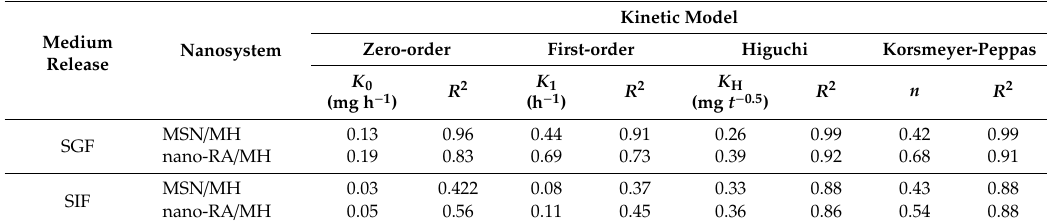
Table 2. Kinetics parameters of the release profile of nanosystems in simulated gastric fluid and simulated intestinal